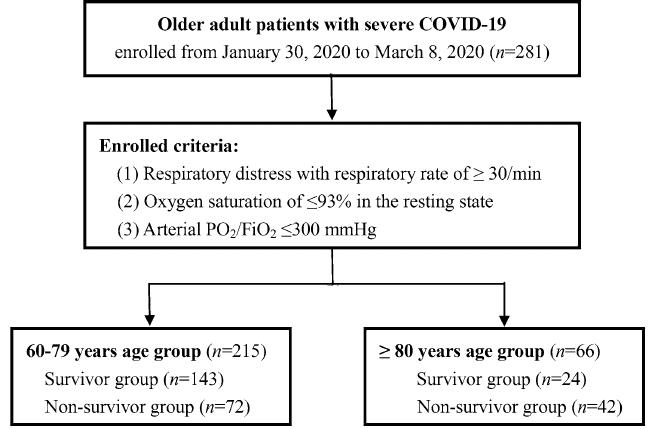
Figure 1. Flowchart of study participants. COVID-19, coronavirus disease